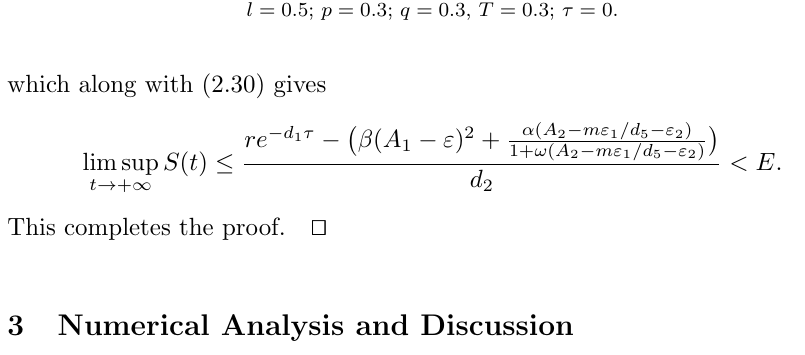
Figure 1. The results of numerical simulation on the threshold values R 1 = 0 . 3608, where l = 0 . 5; p = 0 . 3; q = 0 . 3, T = 0 . 3; τ = 0.